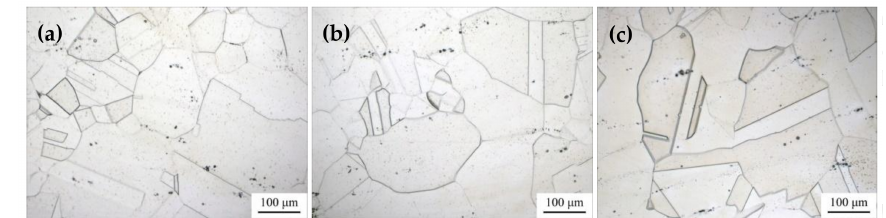
Figure 6. OM micrograph of welding thermal simulation specimens without additional loading after heat treatment: ( a ) 450 ◦ C; ( b ) 550 ◦ C; ( c ) 650 ◦ C.